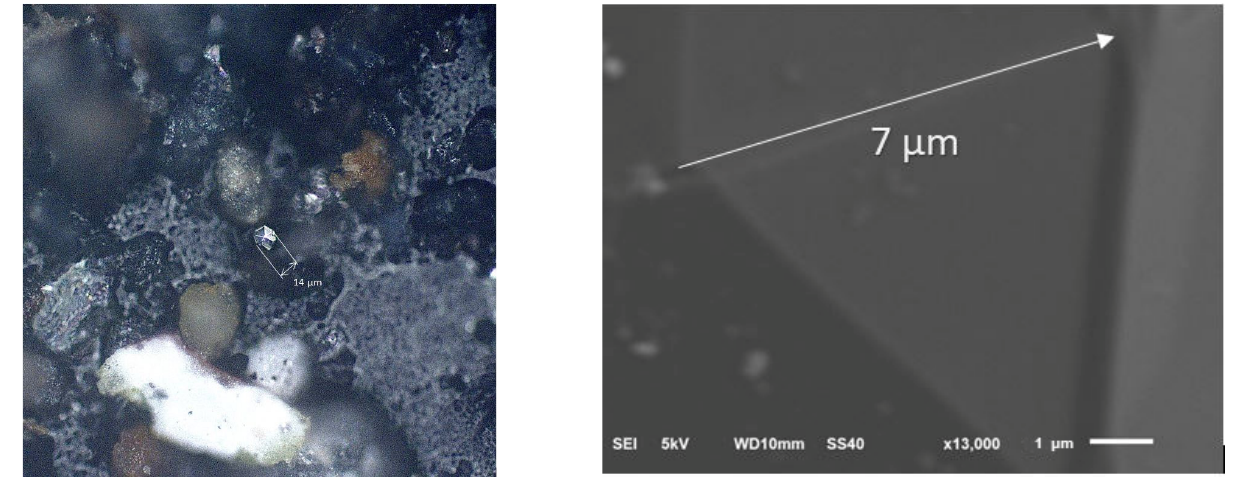
Figure 4. On the ( left ): Optical image of hexagonal ECM particle of 14 μ m maximum dimension. Right: Electron microscopy image of one 7 μ m edge of hexagonal particle presented on the ( right ).